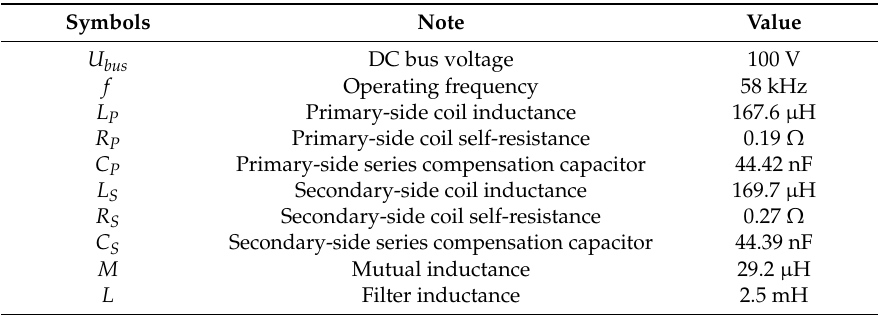
Table 1. Experiment platform parameters.